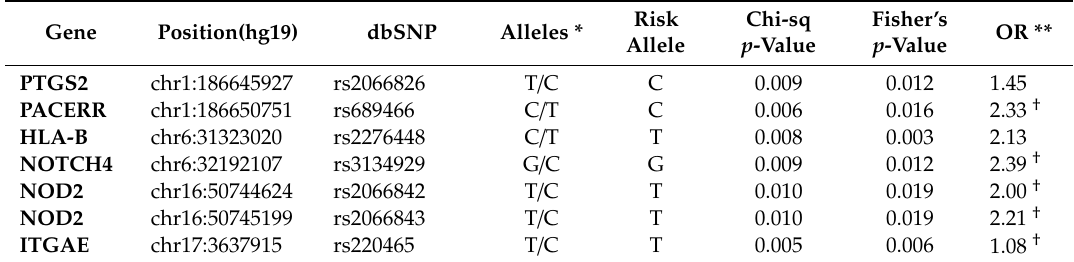
Table 4. Genetic variants associated with extrathoracic organ